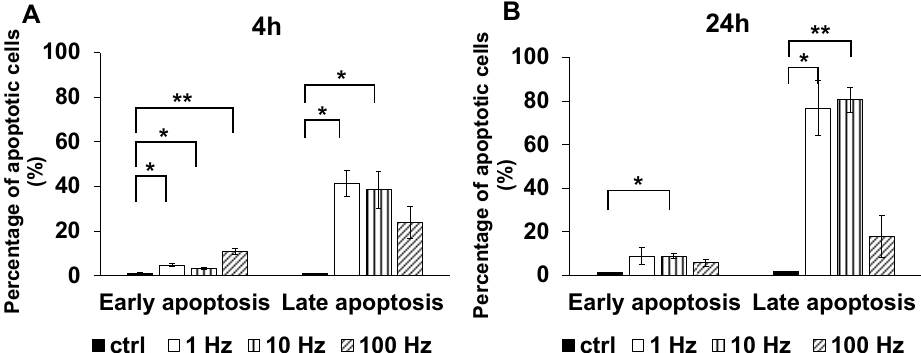
Figure 3. Detection of apoptotic cells 4 and 24 h after US irradiation. TRAMP-C2 cells were irradiated with US and after 4 h ( A ) or 24 h ( B ) an apoptosis detection experiment was performed using flow cytometry ( n = 3). Both early and late phase apoptosis were significantly induced by US irradiation (*: p < 0.05, **: p < 0.01) except for late apoptosis at 100 Hz (4 h and 24 h) and for early apoptosis at 1 Hz and 100 Hz (24 h).